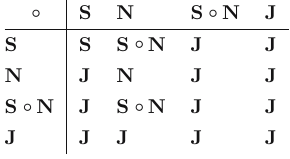
Figure 4: The Cayley table of 〈 S , N 〉